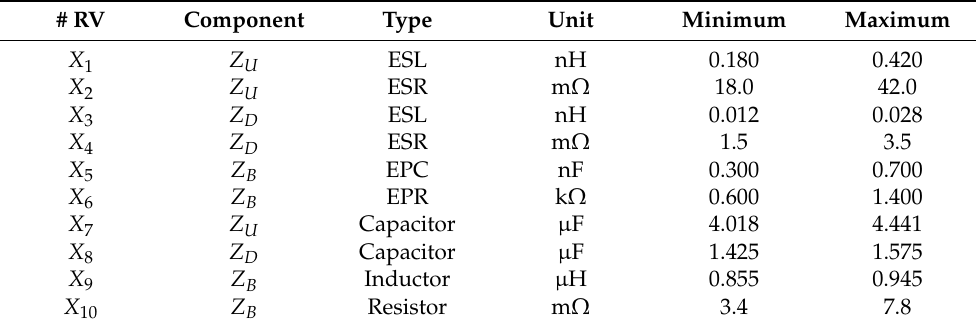
Table 2. UQ with RVs Uniformly distributed involved for test case #1 (Channel #4).